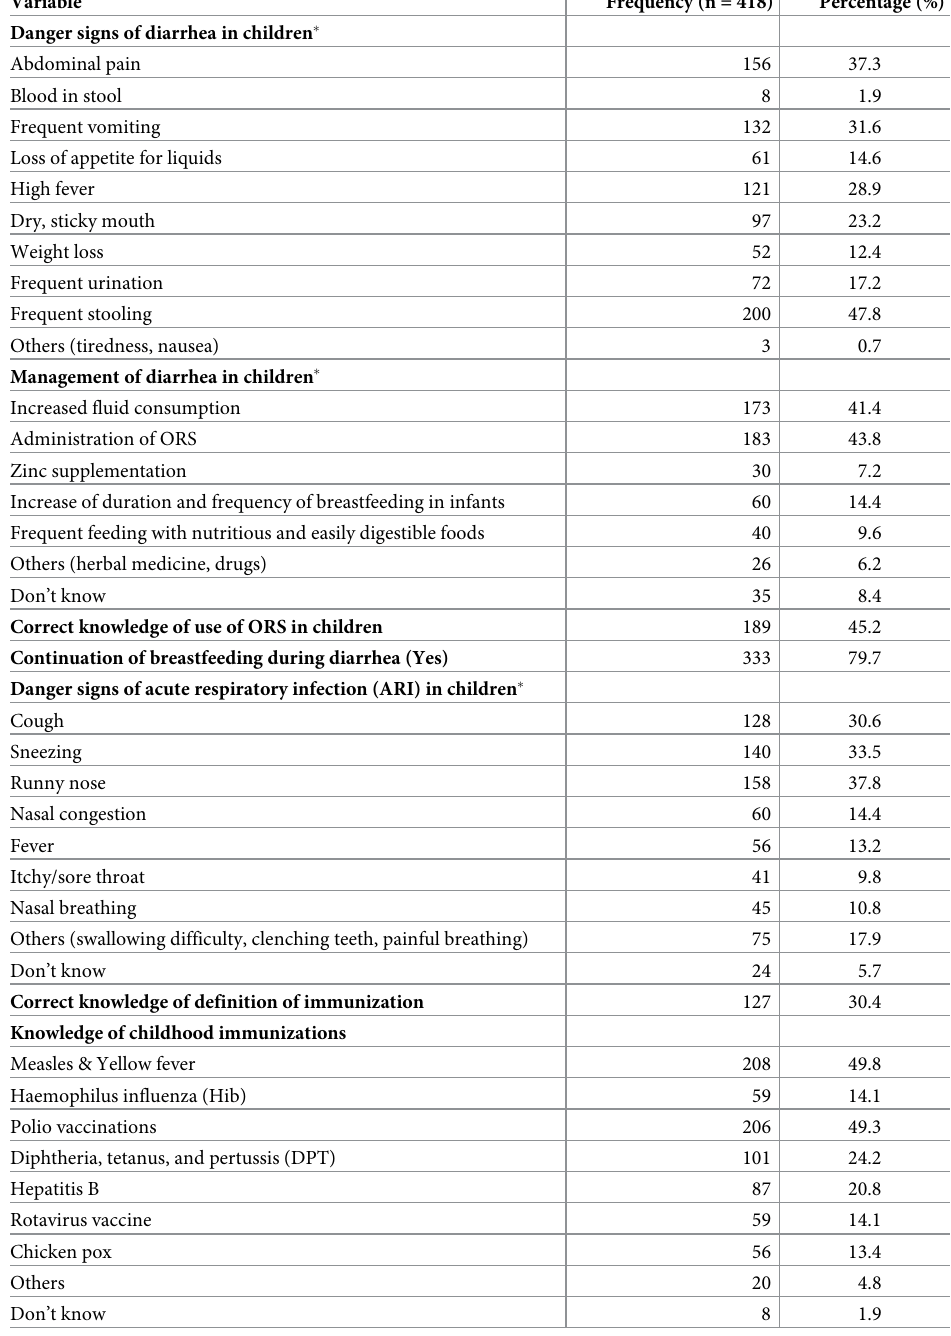
Table 5. Respondents’ knowledge of child health (diarrhoea, ARI,